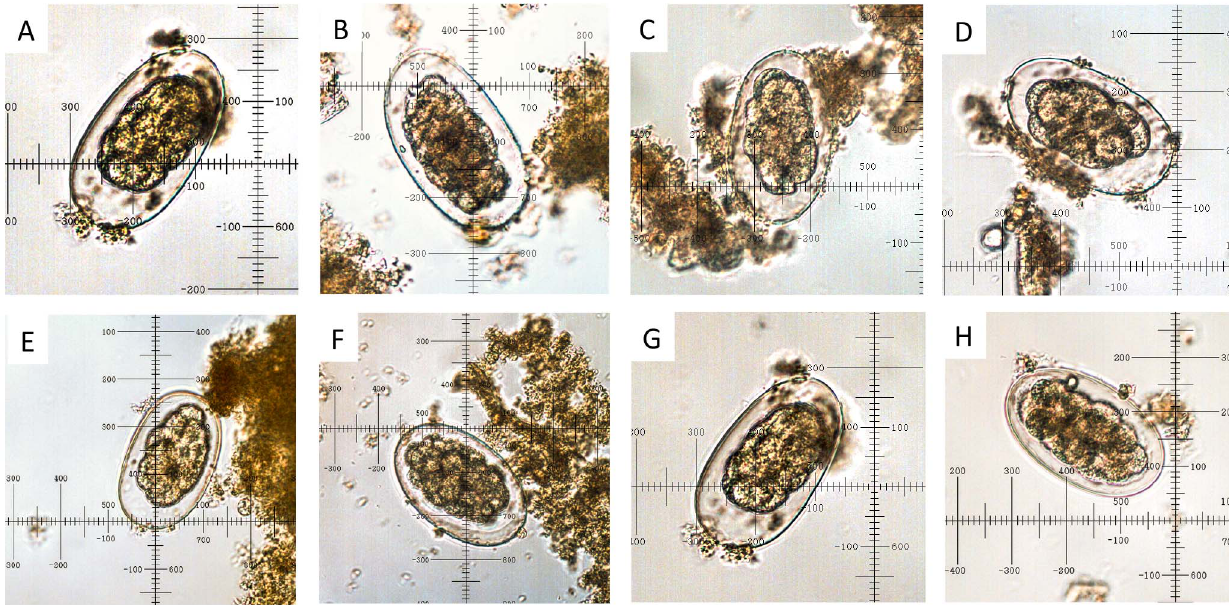
Figure 2. Microscopic images of representative Oesophagostomum sp. eggs found in the feces of infected primate hosts. Images were captured at 40 6 objective magnification from thin smears of sedimented feces. A=blue monkey, B=black and white colobus, C=chimpanzee, D=l’hoest monkey, E=grey-cheeked mangabey, F=olive baboon, G=red-tailed guenon, H=human. All eggs were between 65 and 84 m m long and between 35 and 55 m m wide.